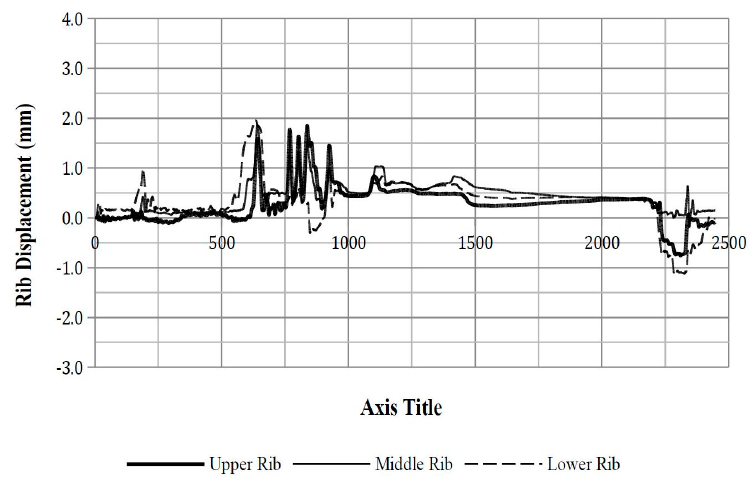
Figure A7. ATD Position 2 rib displacement.